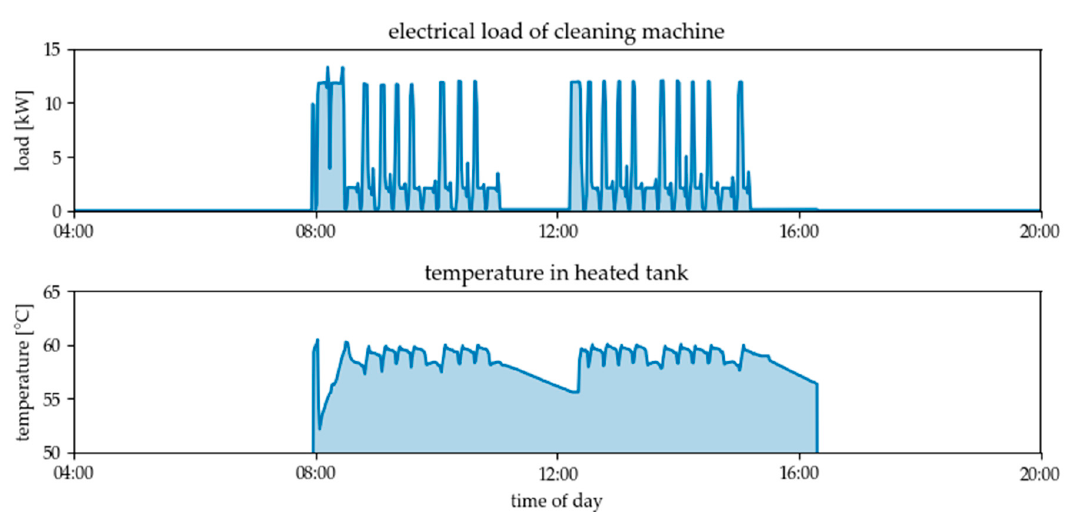
Figure 14. Electrical load profile of the cleaning machine and temperature in the heated water tank on 13.02.2019.